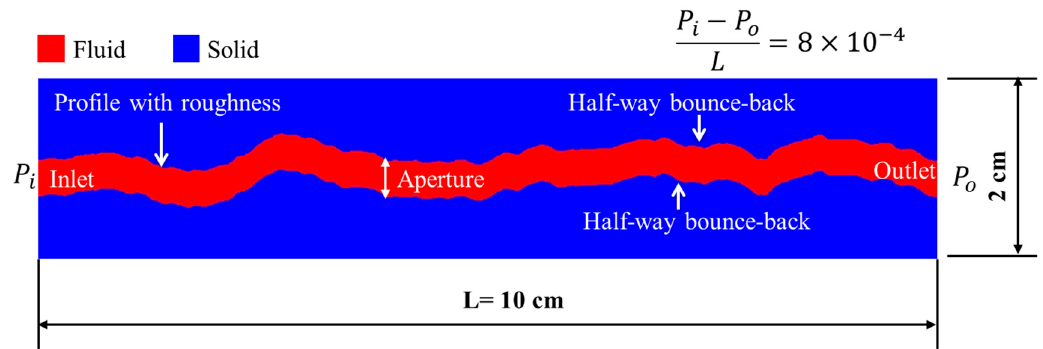
Figure 3. The setup of a fractured model and the boundary conditions.